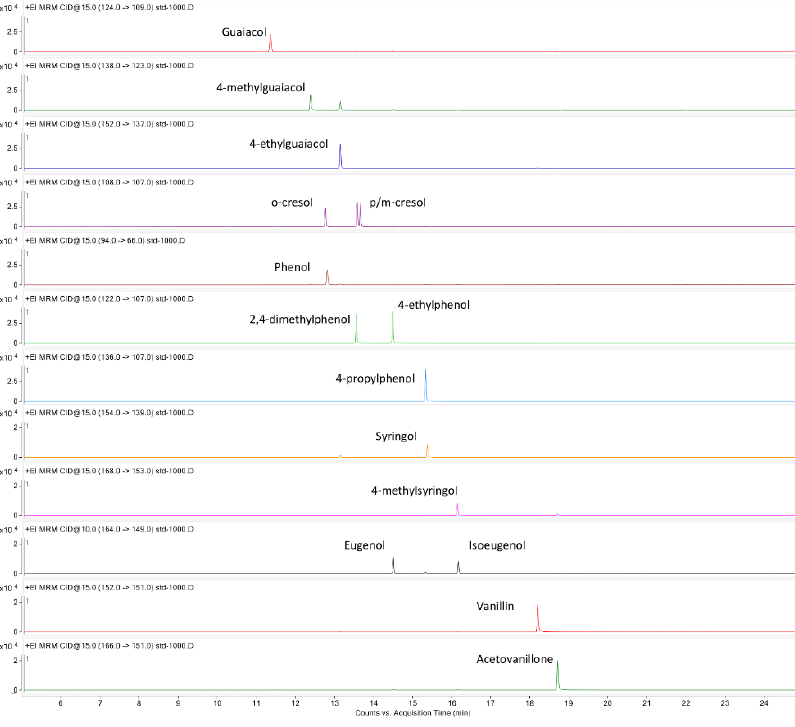
Figure 1. GC-MS / MS profile of 16 phenolic standards acquired in MRM mode. Figure 1. GC-MS/MS profile of 16 phenolic standards acquired in MRM mode. 2.2. Selecting the Optimal Protocol for Extracting Free and Conjugated 2.2. Selecting the Optimal Protocol for Extracting Free and Conjugated Phenols